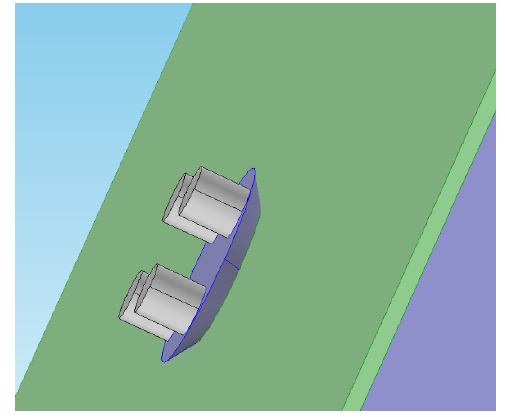
Fig.5: Conical shaped conducting layer placed in between the electrodes and tissue